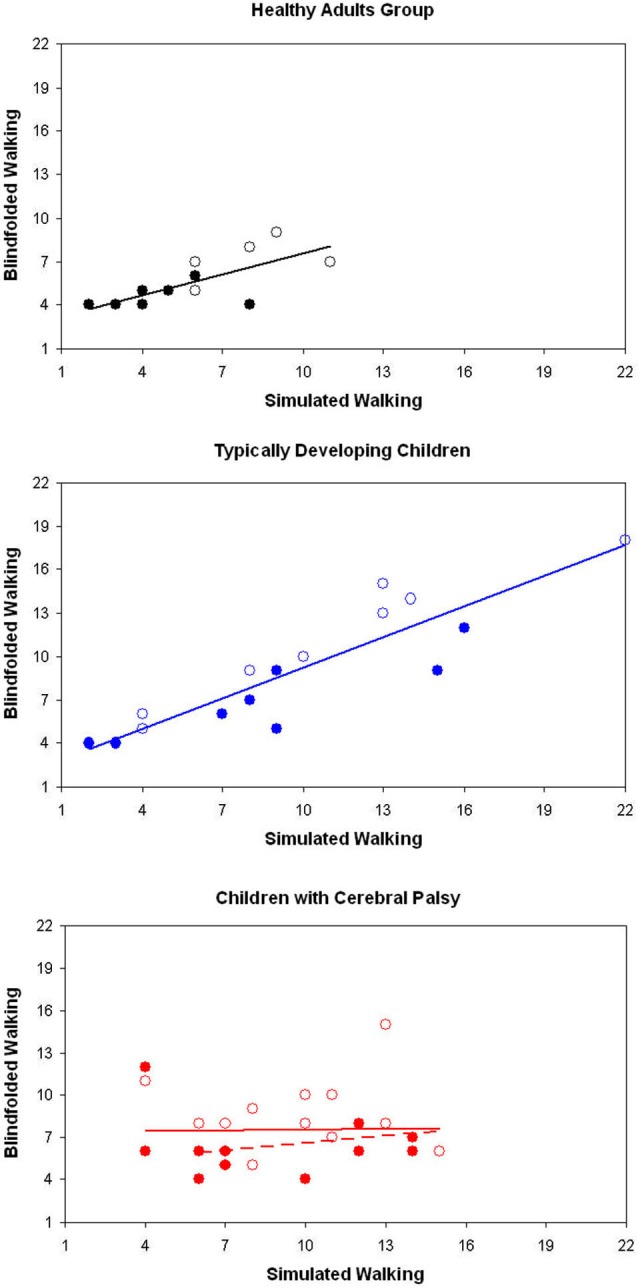
Number of steps recorded during simulated and blindfolded walking for healthy adults (above), typically developing children (in the middle) and children with cerebral palsy (CCP), for the distance of 2 m (filled markers) and 3 m (empty markers). Regression lines are reported in the same color of all the relevant data.